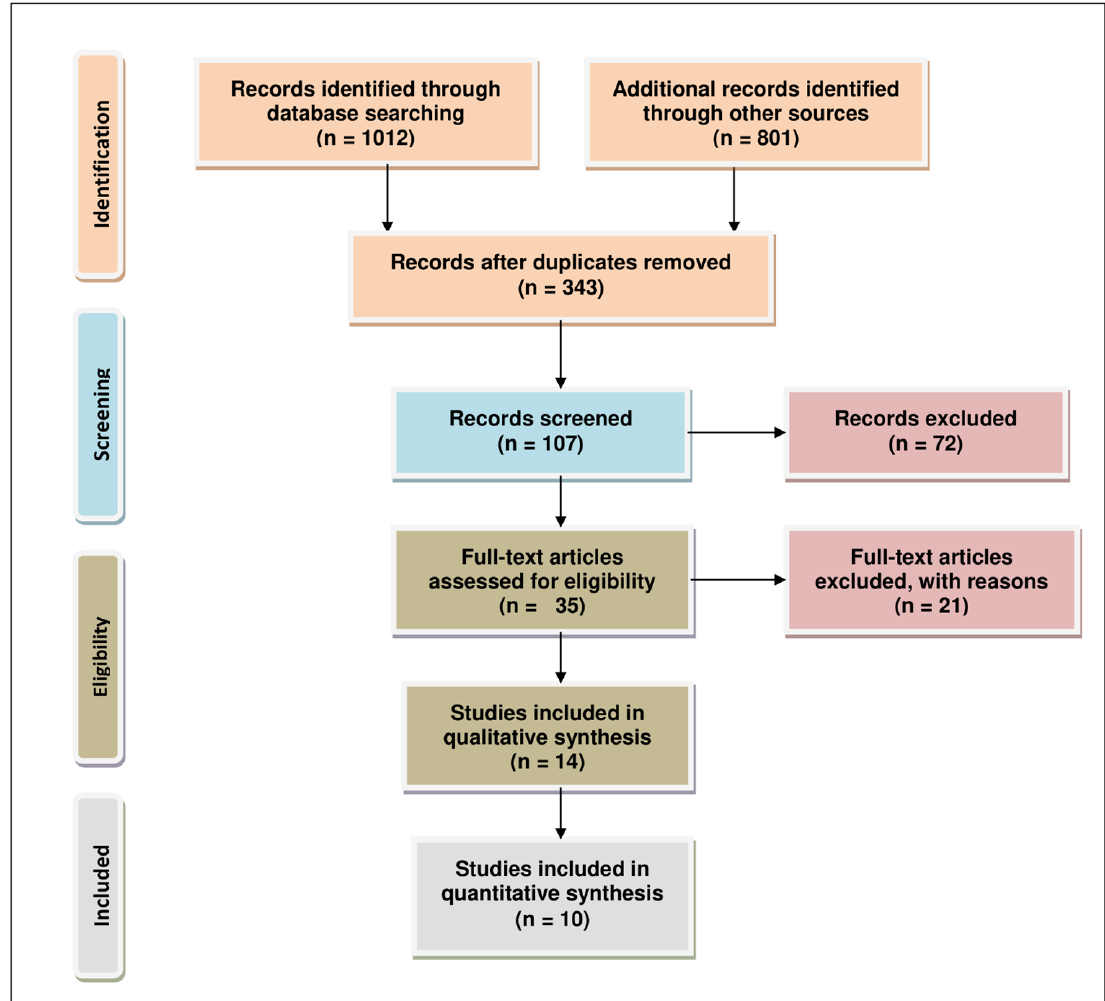
Figure 2. PRISMA flow chart describing the process of literature search and study selection related miRNA, lncRNA, aromatase inhibitor, and ER-positive breast and ovarian cancers. The total number of 10 relevant articles are included in this review.